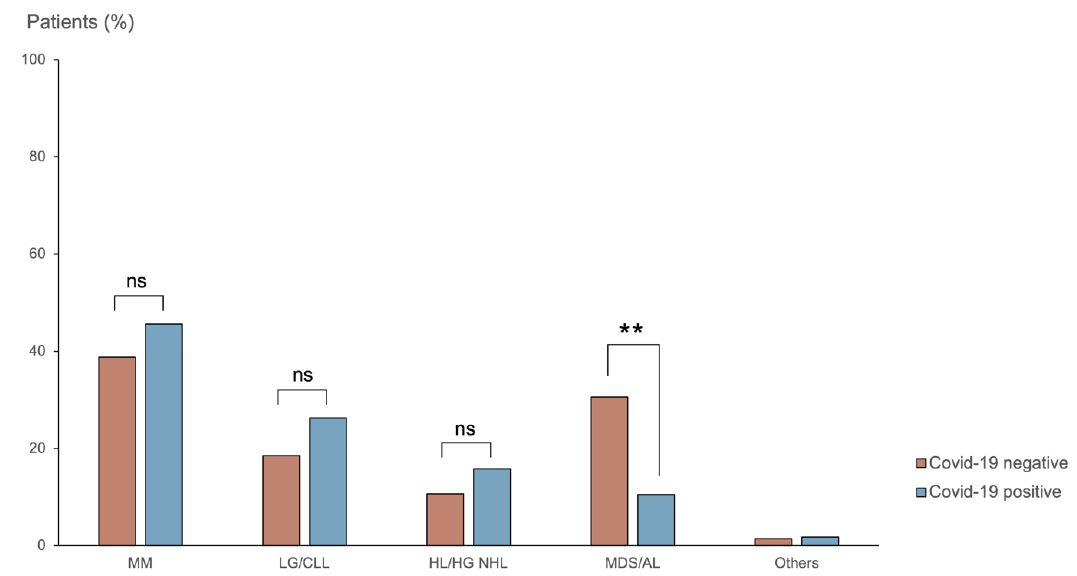
Figure 2. Distribution of hematological malignancies (%) in COVID-19-positive and non-positive patients. Abbreviations: MM, myeloma multiple; LG/CLL, low-grade lymphoma and chronic lym- phocytic leukemia; HL/HG NHL, Hodgkin’s lymphoma and high-grade non-Hodgkin’s lymphoma; MDS/AL, myelodysplastic syndrome and acute leukemia. (**, p < 10 − 2 ; ns, non-significant)